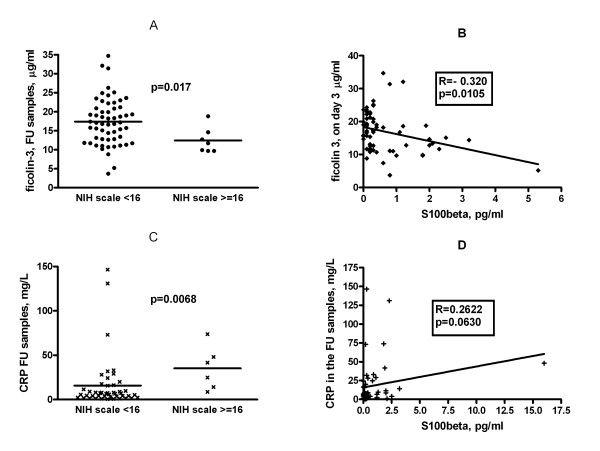
Correlation between ficolin-3 levels with severity and outcome of stroke and size of infarct. Panel A: Negative correlation between serum ficolin-3 levels in follow-up (FU) samples and the severity of stroke as assessed by the NIH stroke scale at admission in 65 patients with ischemic stroke. Patients with unfavorable (≥ 16) vs. favorable (< 16) NIH scale were compared. P value of Mann-Whitney test is indicated. Panel B: Negative correlation between serum ficolin-3 levels in follow-up samples and the size of cerebral infarct as assessed by the S100β level in follow-up samples. Spearman's correlation coefficient and its significance is indicated. Panel C: Positive correlation between serum CRP levels in follow-up samples and the severity of stroke as assessed by the NIH scale at admission in 65 patients with ischemic stroke. Patients with unfavorable (≥ 16) vs. favorable (< 16) NIH scale were compared. P value of Mann-Whitney test is indicated. Panel D: No significant correlation between serum CRP levels in follow-up samples and the size of cerebral infarct as assessed by the S100β level in follow-up samples. Spearman's correlation coefficient and its significance is indicated.